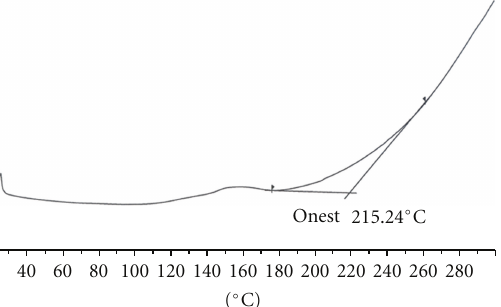
Figure 7: Di ff erential scanning calorimetry oxidation stability curve of